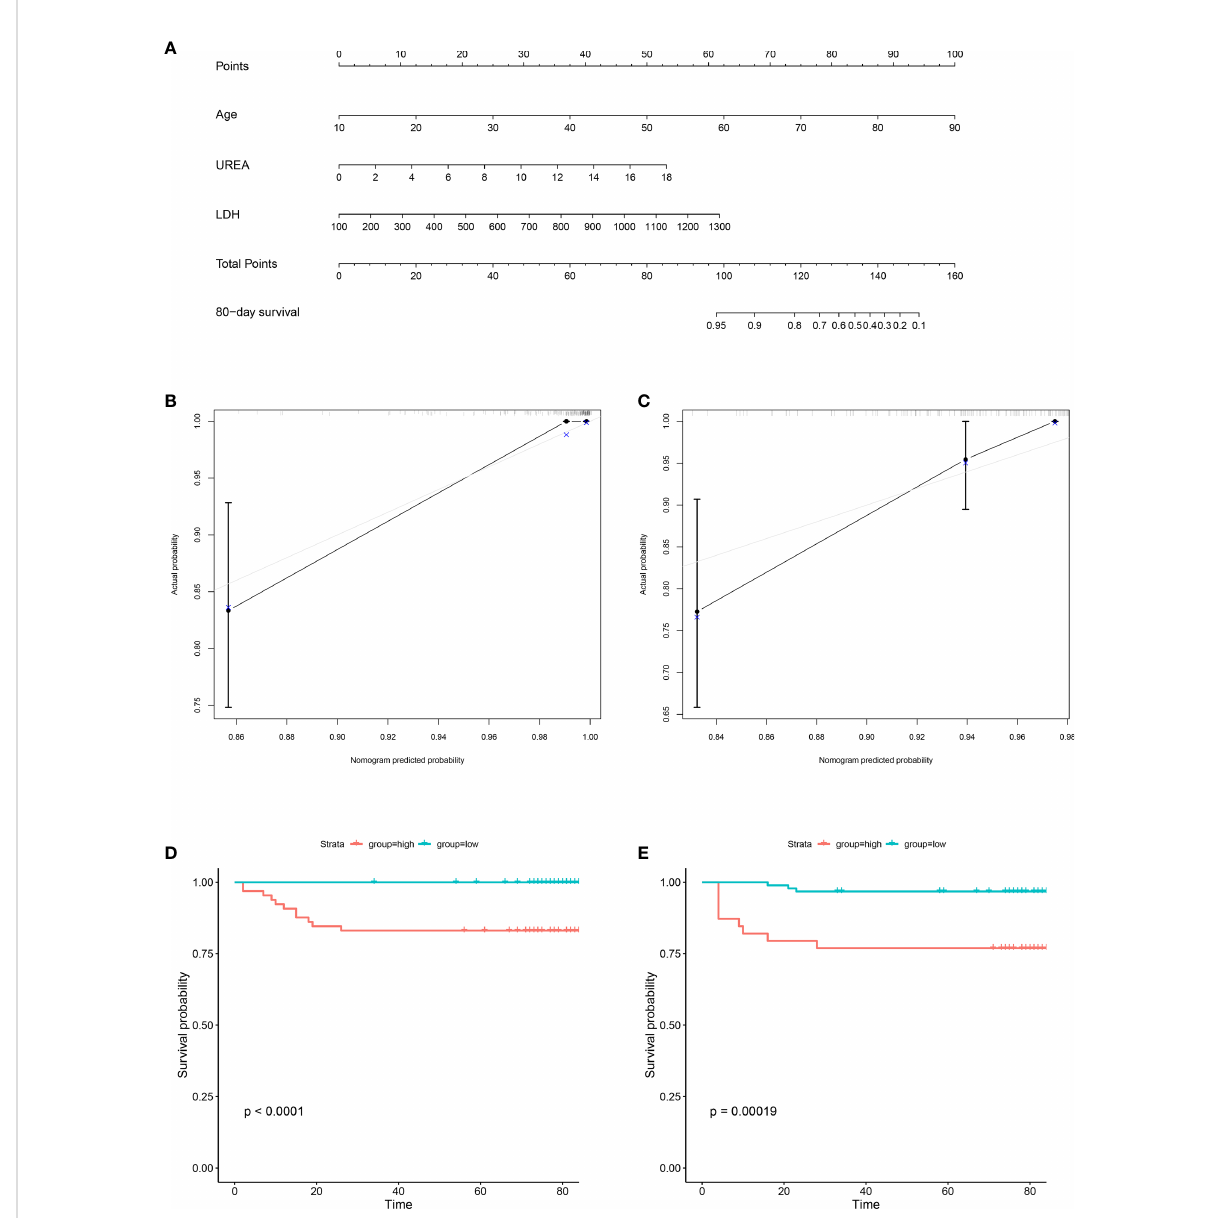
FIGURE 3 Construction of prognostic nomogram for 80-day survival of patients with COVID-19. The prognostic nomogram composed of age, UREA and LDH was developed. (A) Nomogram predicting 80-day survival probability in patients with COVID-19 was plotted. To use this nomogram during clinical practice, each variable axis has a separate parameter, and a line is drawn up to calculate the number of points corresponding to each parameter. The sum of these scores is located on the total point axis, and a line is drawn down along the line to get the 80-day survival probability of patients with COVID-19. (B, C) Calibration plot of the prognostic nomogram. The nomogram was calibrated for the probability of 80-day survival in patients with COVID-19 in the training group (B) and validation group (C) . The predicted probability of 80-day survival is plotted on the x-axis; the actual probability of 80-day survival is plotted on the y-axis (bootstrap 1,000 repetitions). (D, E) Kaplan-Meier Analysis for the patients with COVID-19 in the training group (D) and validation group (E) . Blue line: total points < 86.72142 (low group); red line: total points ≥ 86.72142 (high